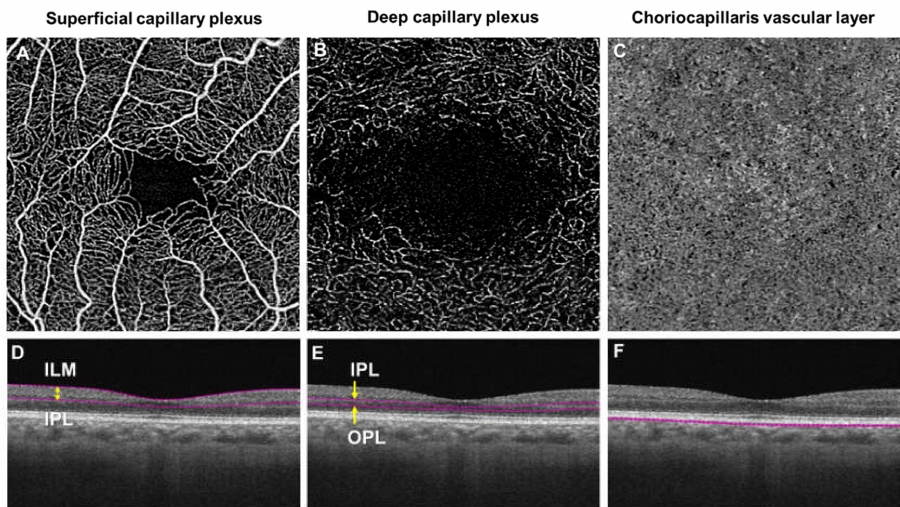
Figure 3. En-face optical coherence tomography angiography (OCTA; 3 × 3 mm area) images (Top row, A – C ) and horizontal B-scan images of their layer-segmentation (Bottom row, D–F) of a healthy control individual. ( A ) OCT angiogram of a superficial vascular plexus centered on the macula. ( B ) The OCT angiogram of a deep capillary plexus centered on the macula. ( C ) An OCT angiogram of a choriocapillaris vascular layer centered on the macular. ( D ) The en-face image of the superficial plexus was segmented from the internal limiting membrane (ILM) to the inner plexiform layer (IPL). ( E ) The image of the deep plexus was segmented from the IPL to the outer plexiform layer (OPL). ( F ) The OCT angiogram of the choriocapillaris layer was segmented within a thin 10 µ m thick slab (31–40 µ m) below the retinal pigmented epithelium. The foveal avascular zone (FAZ) is visibly larger in the deep plexus ( B ) than superficial plexus ( A ). ( B , C ) were created after removal of projection